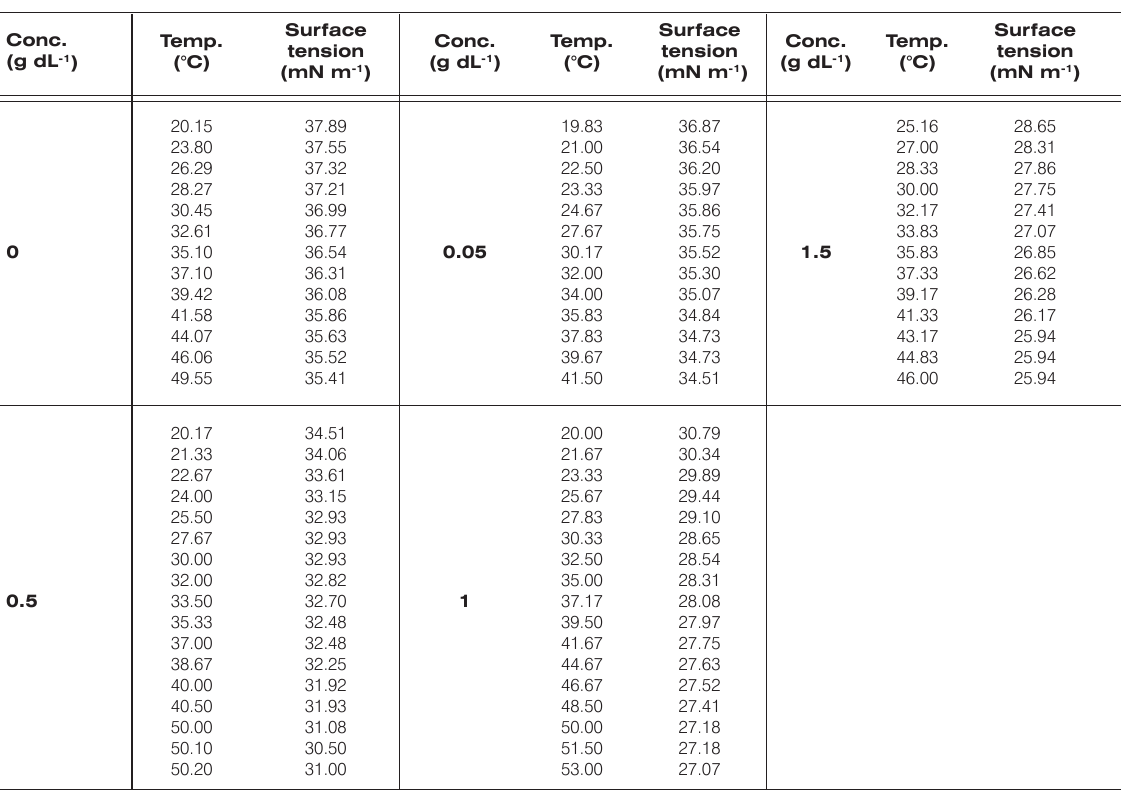
Table 1. Variation of surface tension with concentration and temperature. Conc. (g dL -1